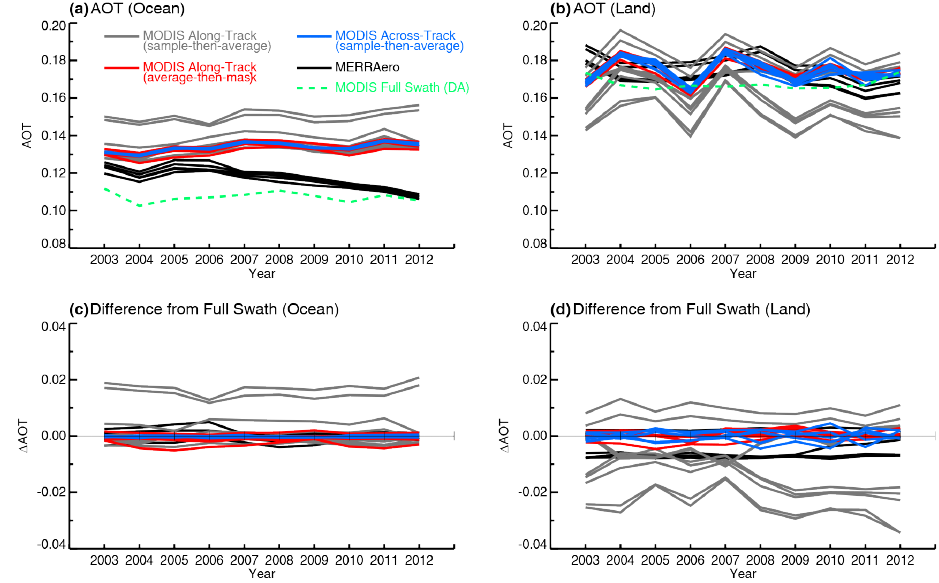
Figure 4. A time series for the years 2003–2012 of the global, annual mean MODIS Aqua AOT over ocean (a) and land (b) . Grey shaded lines are the MODIS along-track sample-then-average approach. Red lines are the MODIS along-track average-then-mask approach. Blue lines are the across-track sampling following Geogzhayev et al. (2013). Black lines are the MERRAero along-track sampling. Different lines within each color group are the various sampling candidates explored. The bottom panels (c, d) in each is the difference of the individual sub-sampled averages from the respective full-swath average. Individual MERRAero sub-samples are differenced relative to the MERRAero full-swath (Aqua) sampling. Others are relative to the MODIS Aqua full-swath sampling. On top panels only, green dashed line is the data assimilation (DA) grade MODIS AOT assimilated in MERRAero (see